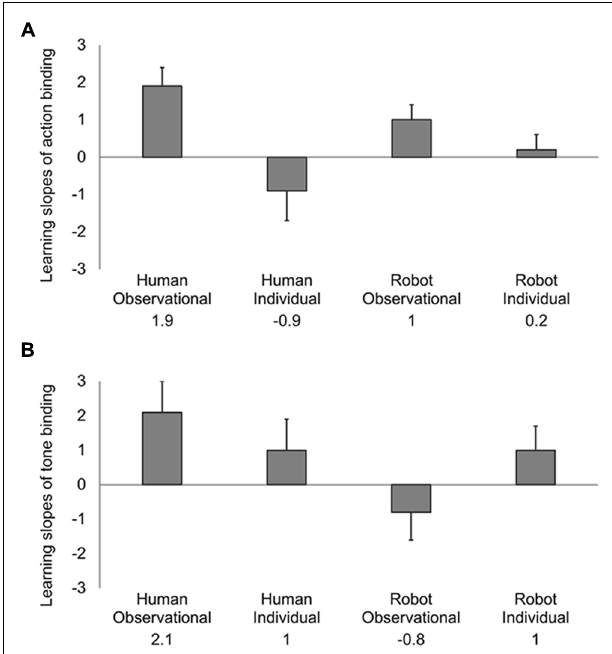
FIGURE 3 | Changes of intentional binding over trials, plotted separately for (A) action binding and (B) tone binding. The values on vertical axes are regression slopes (changes of binding in ms per trial). A positive slope for this regression would correspond to an increase in action binding with progressive exposure to the other’s action, but a decrease in tone binding, because of the negative sign of tone binding. Error bars show standard